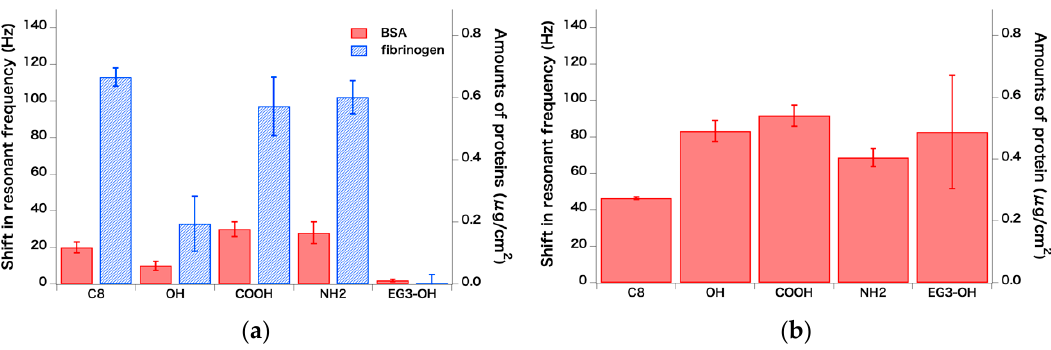
Figure 5. Amounts of adsorbed proteins and changes in the resonant frequency measured by QCM. ( a ) Adsorption of BSA and fibrinogen from 1 mg/mL solution in PBS ( n = 4) and ( b ) adsorption of serum proteins from 20% serum diluted with PBS ( n = 3). Error bars and n denote standard deviation and the number of measurements, respectively.